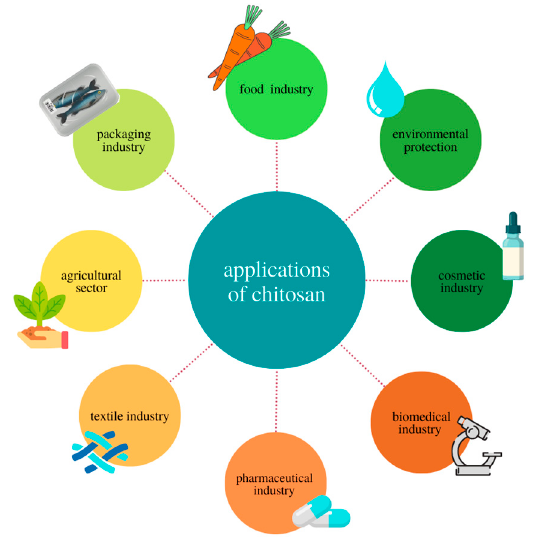
Figure 1. Application of chitosan.